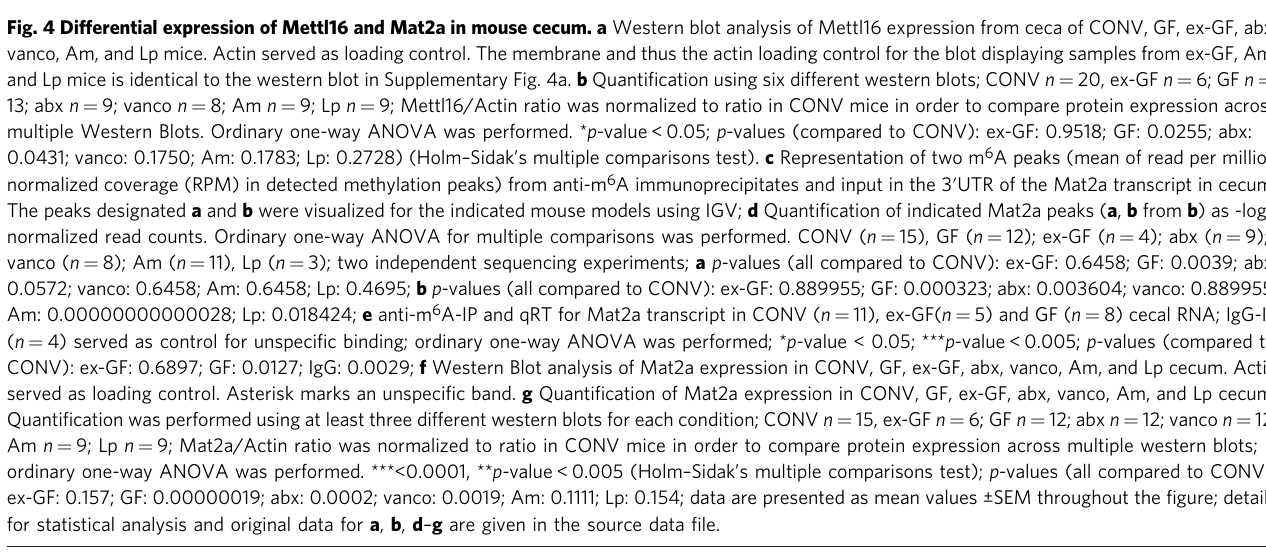
Fig. 1d, Supplementary Fig. 4b, c), and its mRNA levels were only